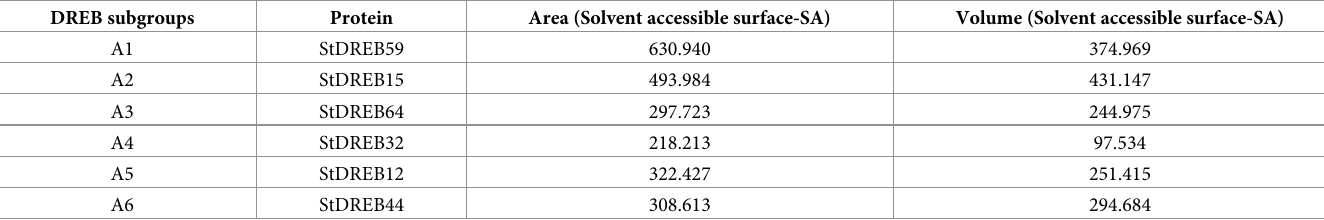
Table 3. Predicted area and volume of the StDREB proteins’ active catalytic site using CASTp server. DREB subgroups